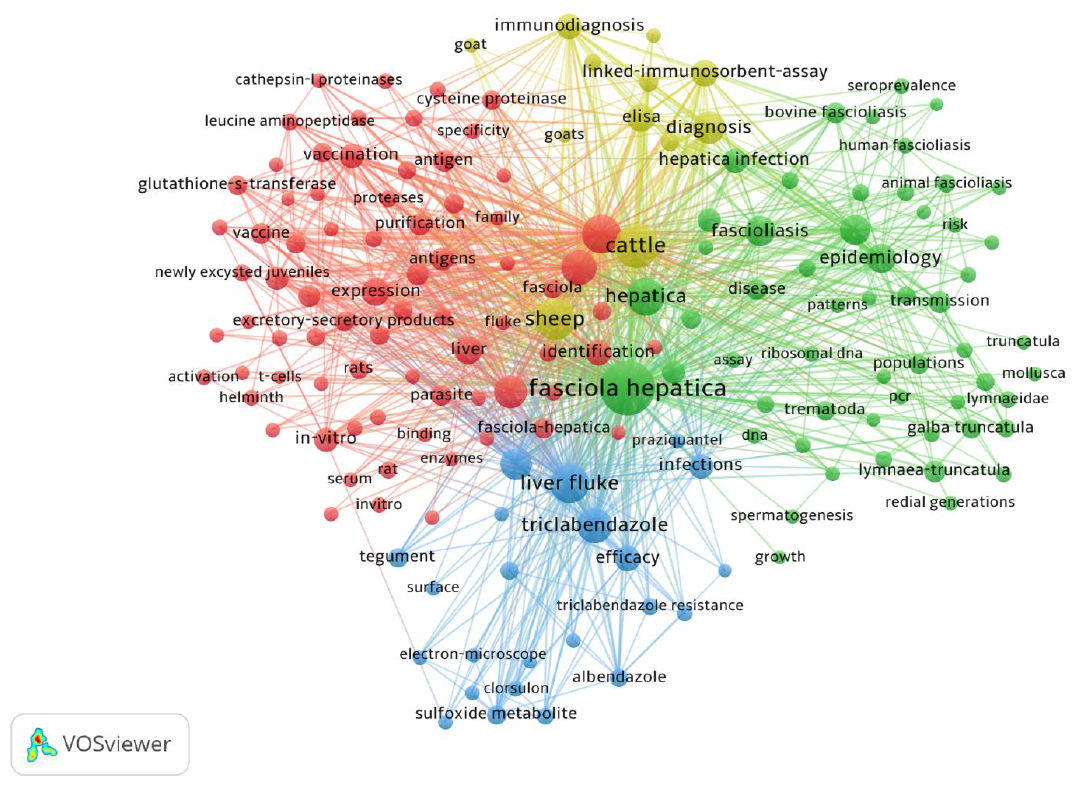
Figure 5. Network visualization of co-occurrences of all keywords based on occurrences.